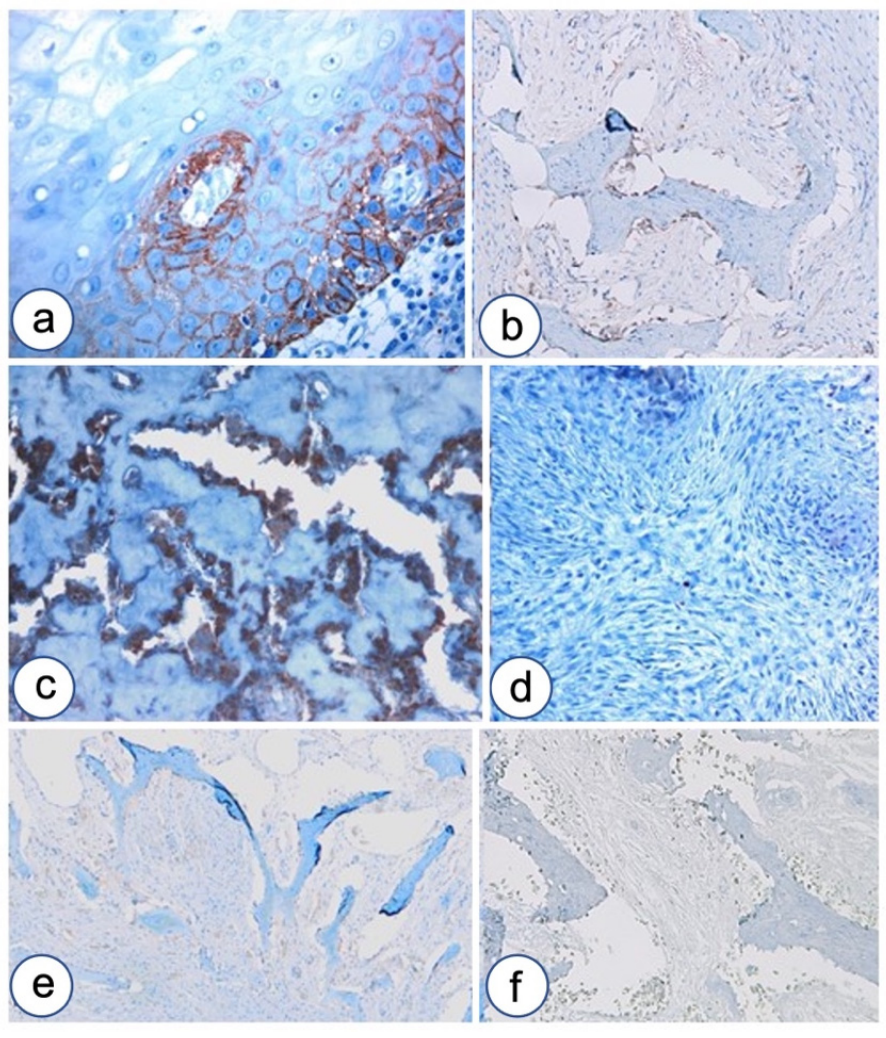
Figure 6. P-cadherin and E-cadherin expression in FD of the jaw. ( a ) P-cadherin expression in oral epithelium. ( b ) P-cadherin expression in remodeling bone surrounding developmental odontogenic cyst. ( c ) P-cadherin over-expression in pagetoid FD is confined to osteoblasts. ( d ) P-cadherin negative staining in fibrous area of FD without osteoid formation. ( e ) E-cadherin shows faint staining in remodeling normal bone. ( f ) E-cadherin negative staining in FD of the jaw. Magnifications, × 4 ( e , f ), × 10 ( b , c ), × 20 ( a , d ).